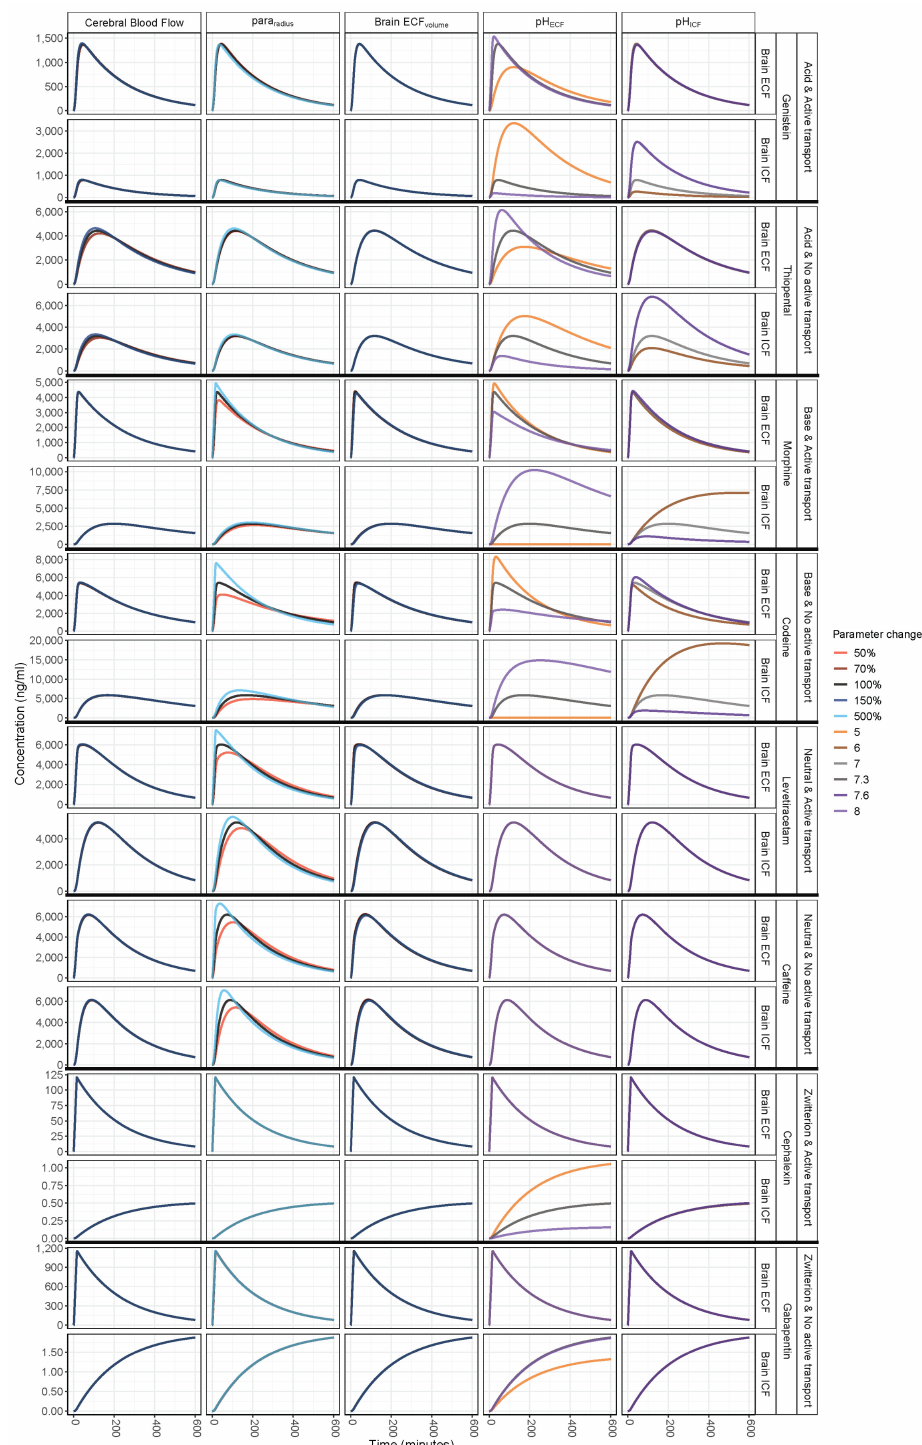
Figure 2. Simulated concentration–time profiles of selected drugs at physiological and pathophysiological values of CBF, tight junction paracellular pore radius (para radius ), brain ECF volume, pH ECF , and pH ICF . Para radius affected the rate and extent of passive drug transport across the BBB, pH ECF and pH ICF affected the brain ECF and brain ICF unbound drug concentration-time profile (PK), whereas cerebral blood flow and brain ECF volume had a very modest (if any) effect. The fixed plasma PK used excludes the involvement of plasma PK in the observed